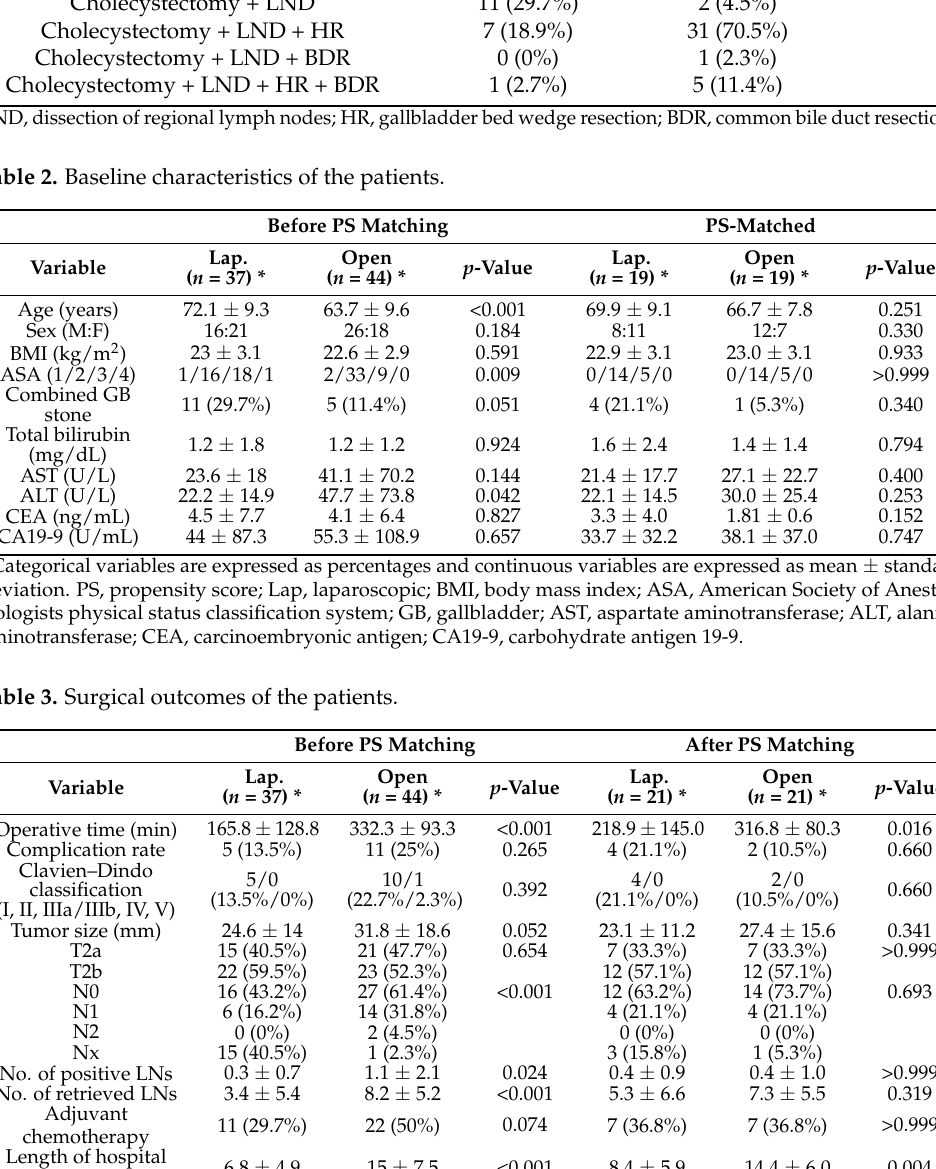
Table 1. Comparison of surgery type in patients before propensity-score matching. Laparoscopic Type of Surgery